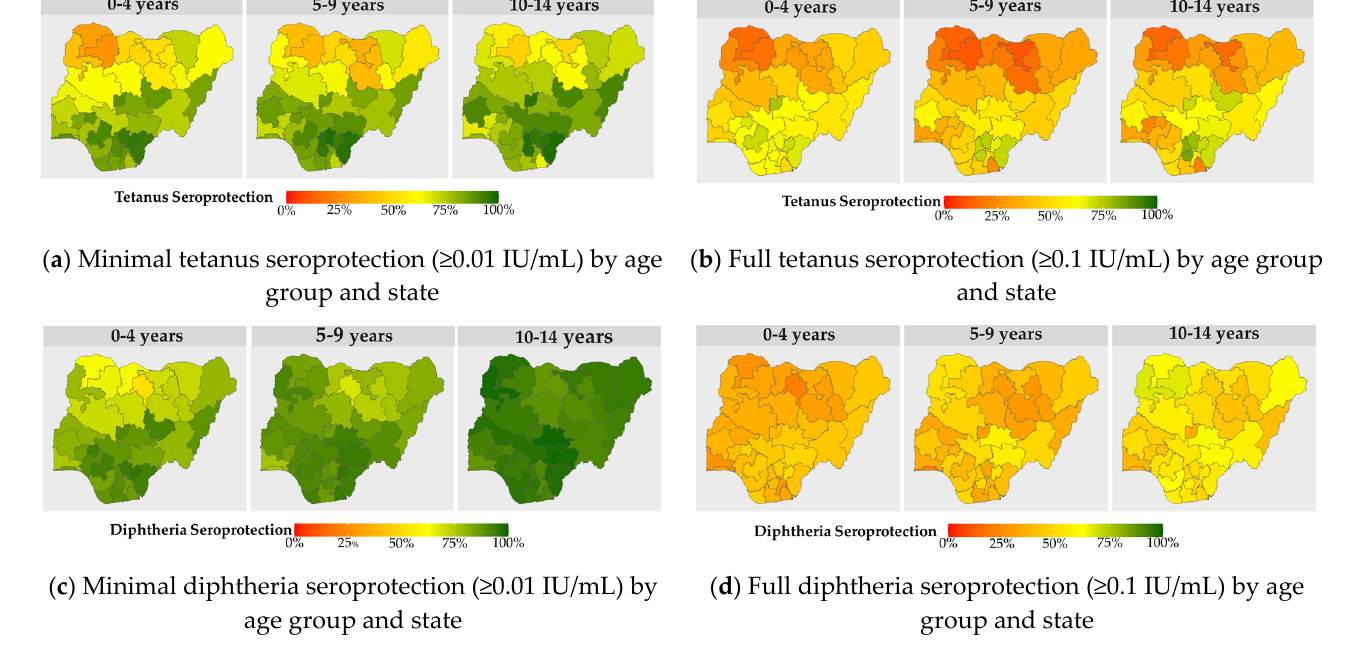
Figure 1. Tetanus and diphtheria minimal and full seroprotection among children aged <15 years by age group and state, Nigeria, 2018 ( a – d ).